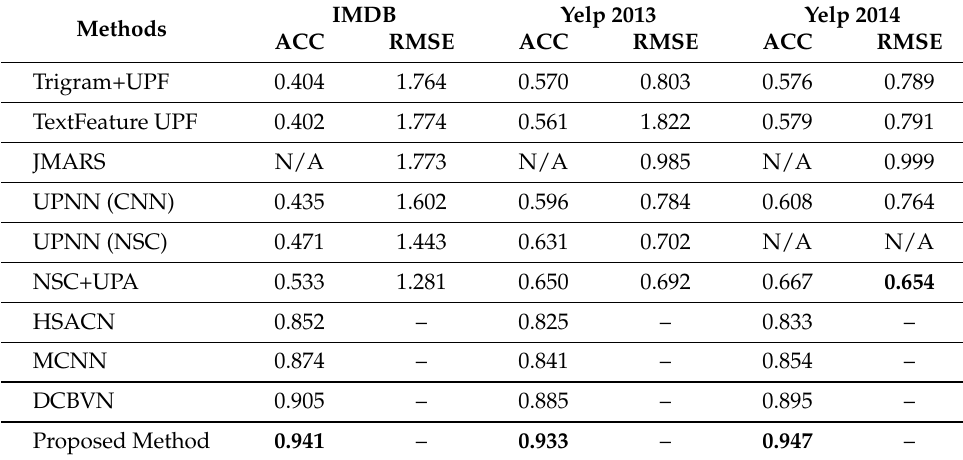
Table 4. Comparison of proposed spider Taylor-ChOA-based HAN with existing methods, in terms of accuracy (ACC) and RMSE. The best results are displayed in